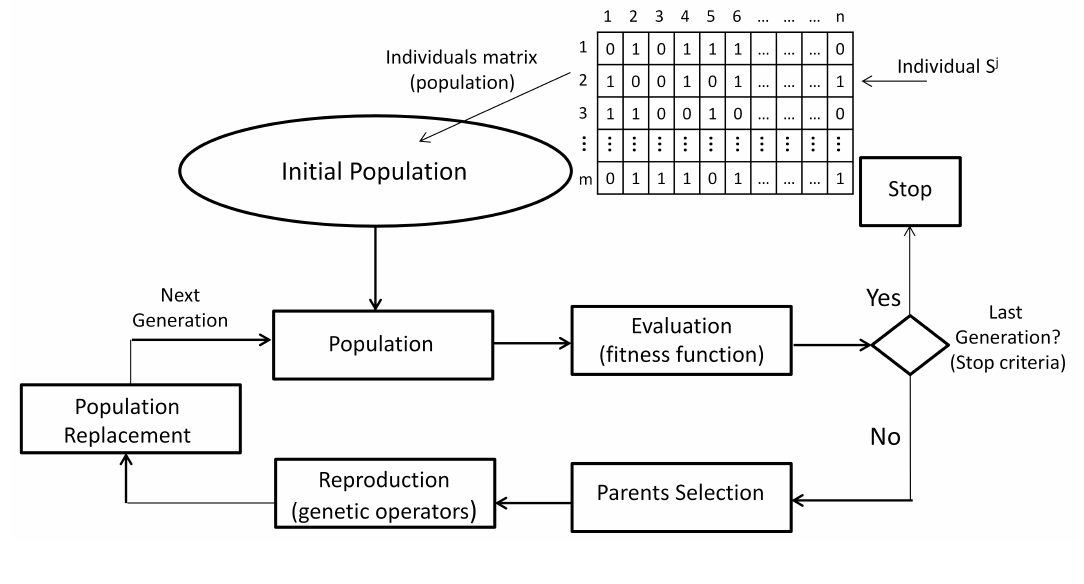
Figure 1. General cycle of the